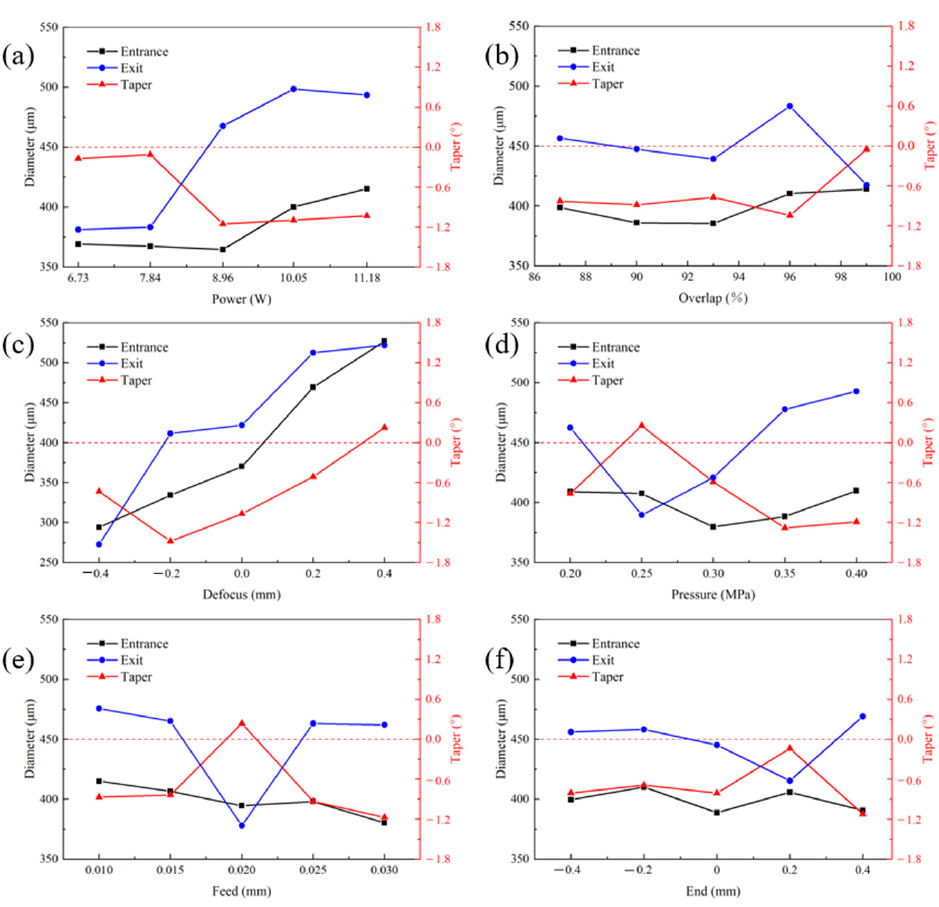
Figure 14. Effect of relevant parameters on DD6 single crystal superalloy. ( a ) power; ( b ) overlap; ( c ) defocus; ( d ) pressure; ( e ) feed; ( f ) end. ( c ) defocus; ( d ) pressure; ( e ) feed; ( f )